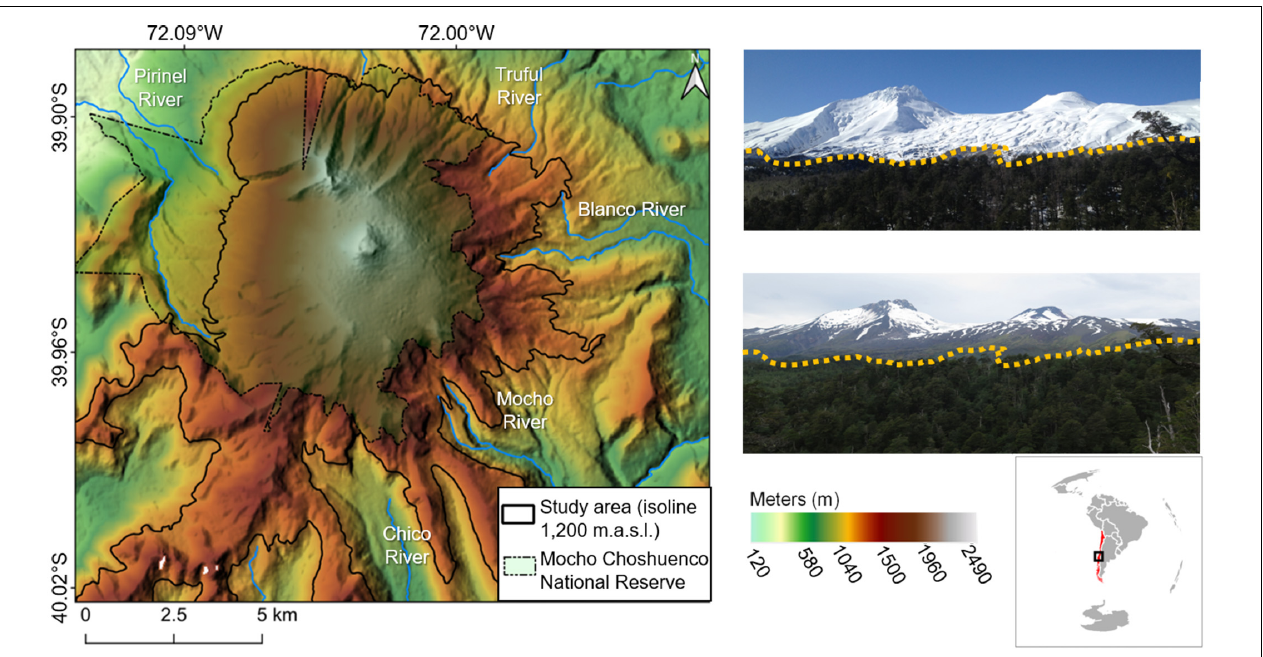
FIGURE 1 | Study area comprising the alpine area above the tree-line of the Mocho Choshuenco volcano in Southern Chile, with a total area of 137 km 2 . The tree line (1,200 m.a.s.l.) is indicated in the pictures by dotted yellow lines.